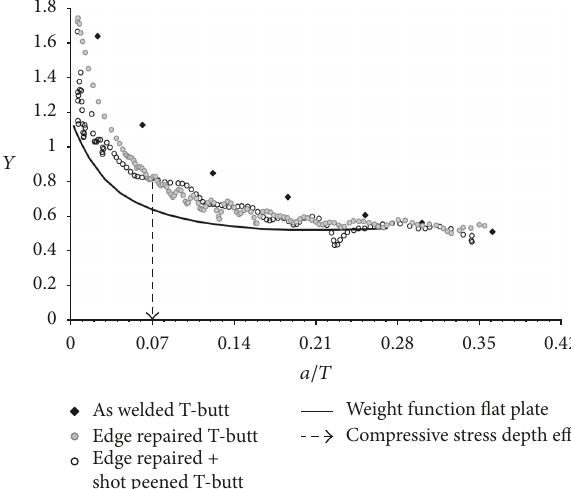
Figure 11: Experimental 𝑌 factors and estimation of residual compressive stress depth